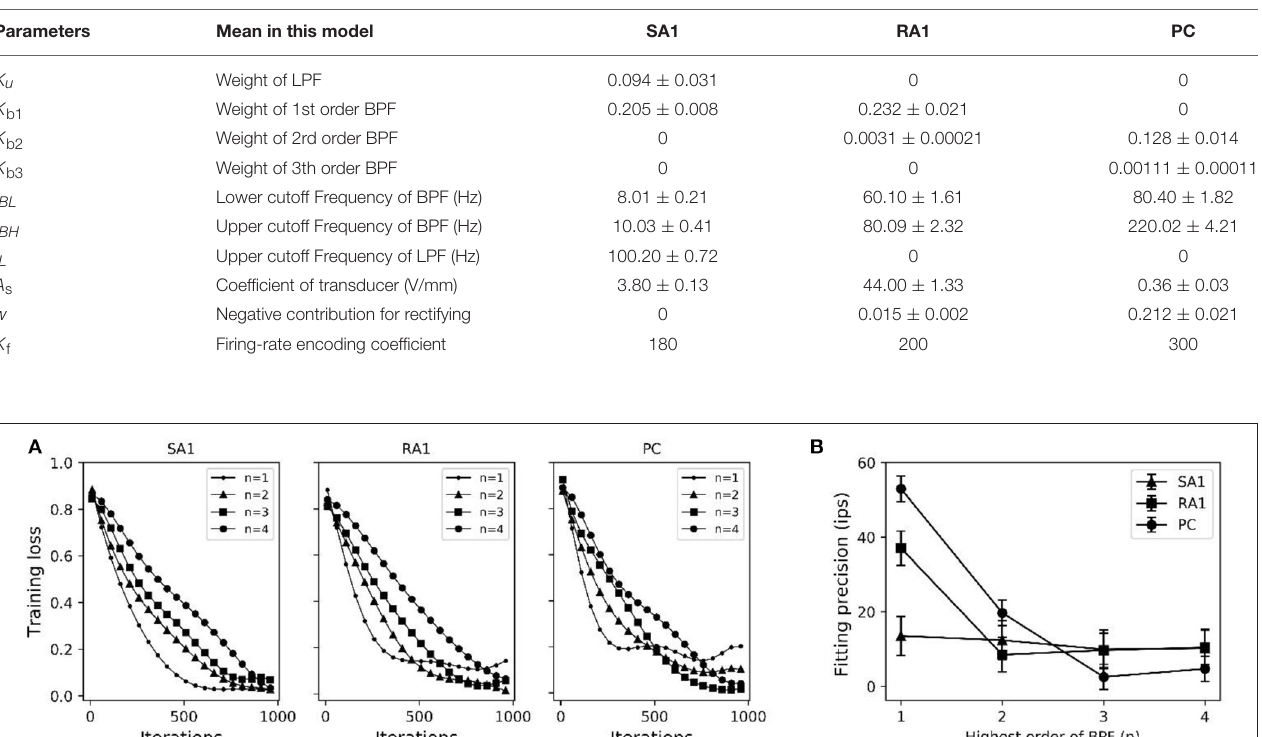
TABLE 1 | Summary of parameters (mean ± SD).